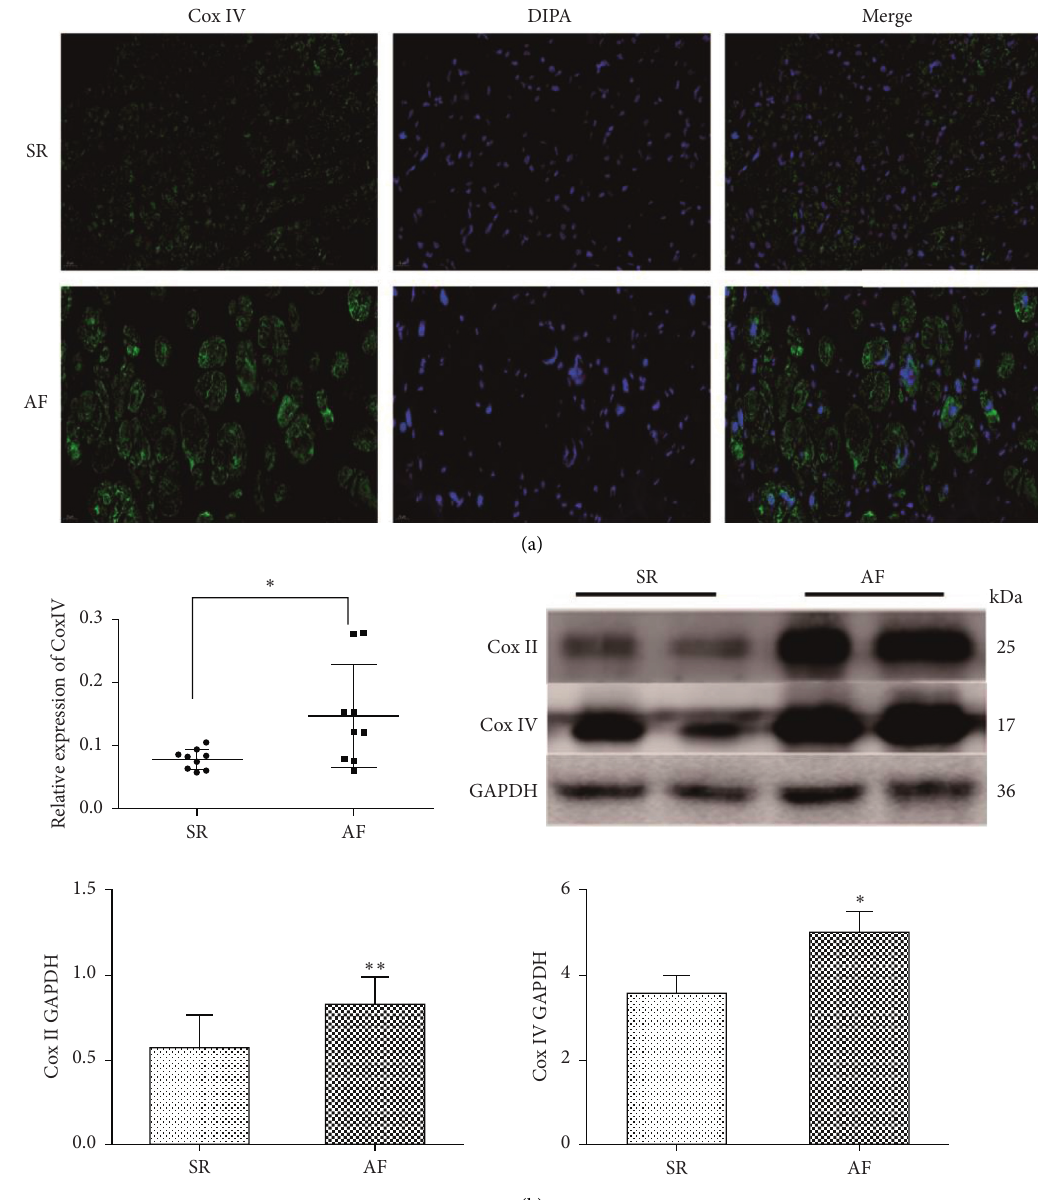
Figure 3: Defective mitophagy in atrial myocytes of patients with chronic AF. (a) Representative immunofluorescence images and semiquantitative analysis of Cox IV in RAA ( n � 9 per group, scale bar � 20 μ m). (b) Representative western blots and quantification of protein expressions of Cox II and Cox IV in RAA (the SR group, n � 14; the AF group, n � 18). ∗ p < 0.05, ∗∗ p < 0.01 vs the SR group. SR, sinus rhythm; AF, atrial fibrillation; RAA, right atrial